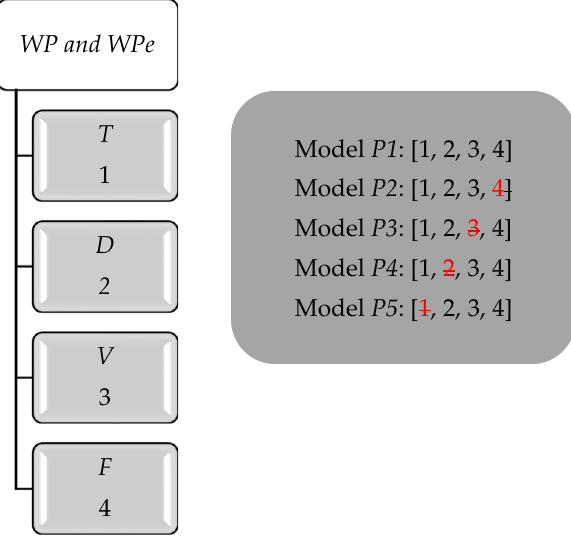
Fig. 5 Combination of input scenarios in WP and WPe